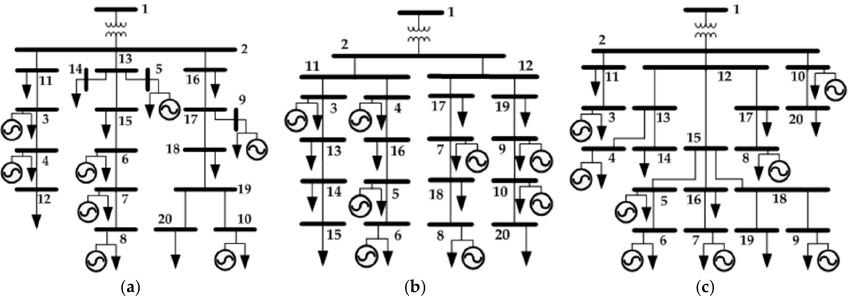
Figure 3. Three test low-voltage systems: 20 buses and 8 generators. ( a ) Low-voltage system 1; ( b ) low-voltage system 2; and ( c ) low-voltage system 3. Table 1. Low-voltage system generation data and inverter power loss constants. Bus No.